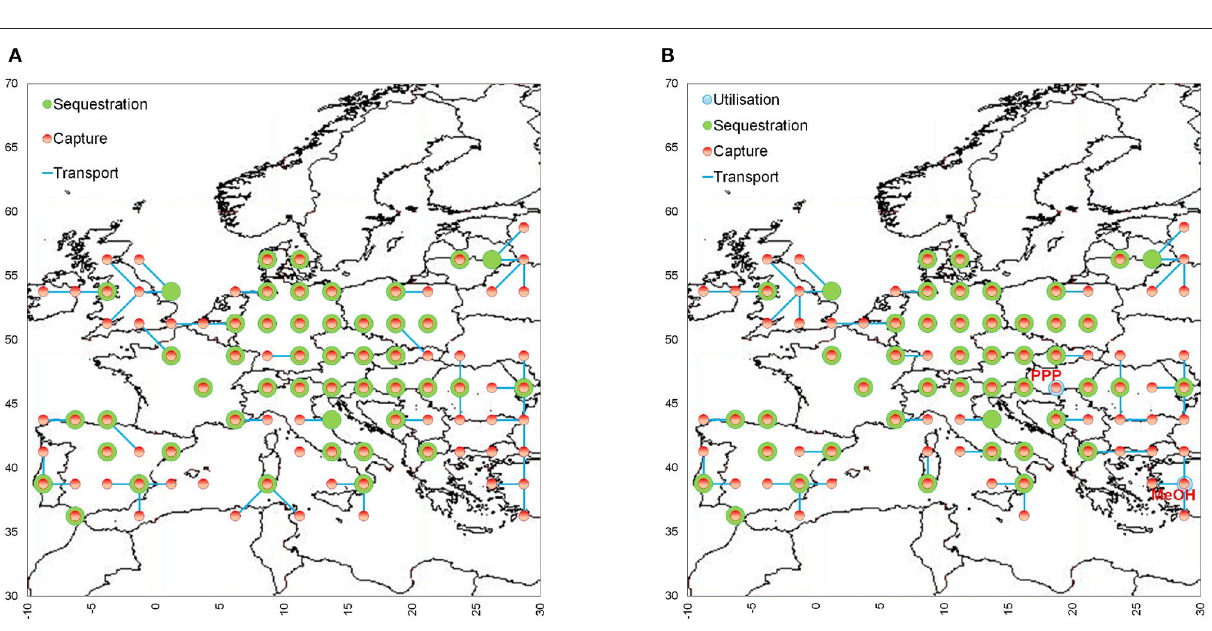
FIGURE 4 | Final SC configurations for (A) Scenario 0 and (B) Scenario A D 1